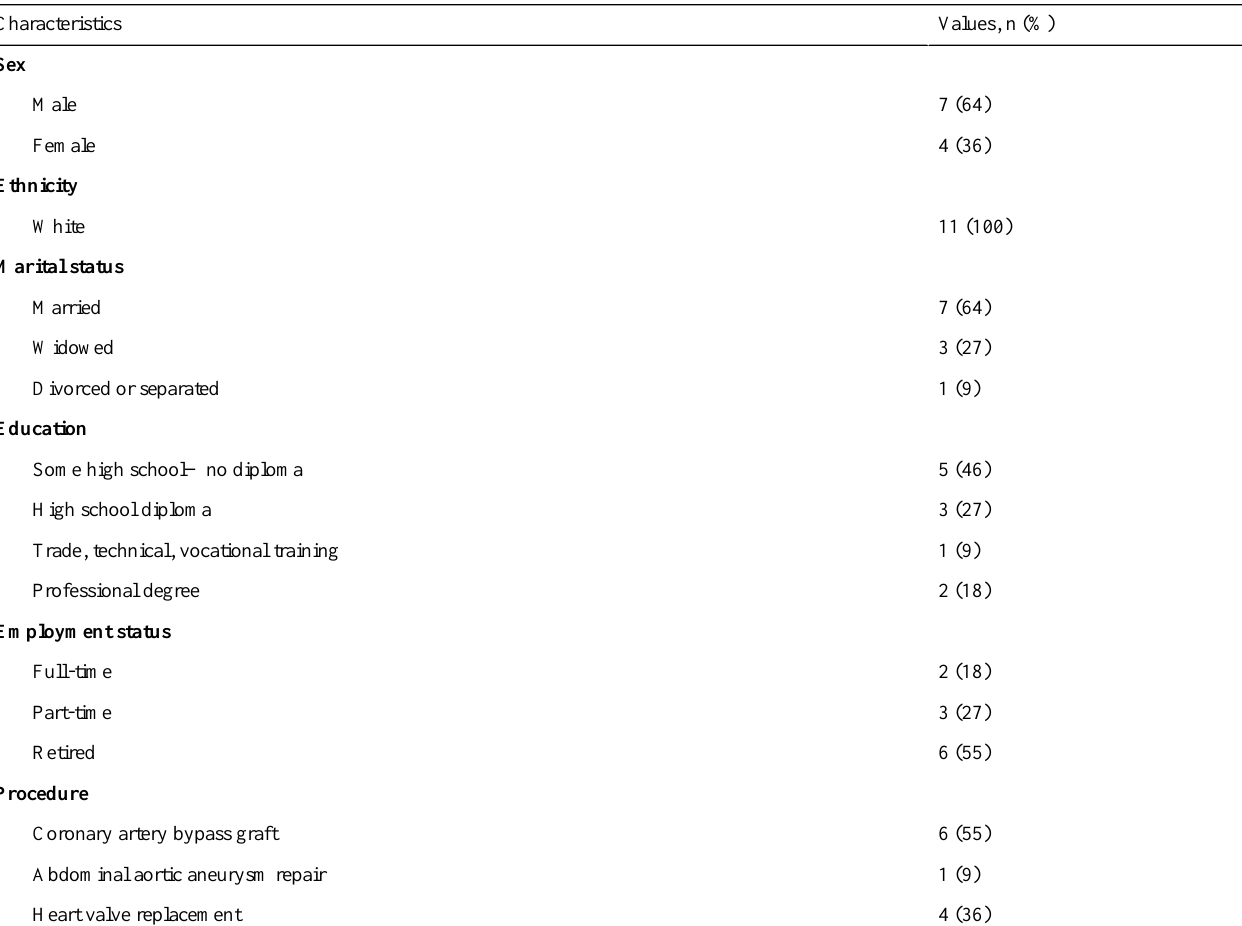
Table 2. Electronic Transition to Ambulatory Care patient participant characteristics